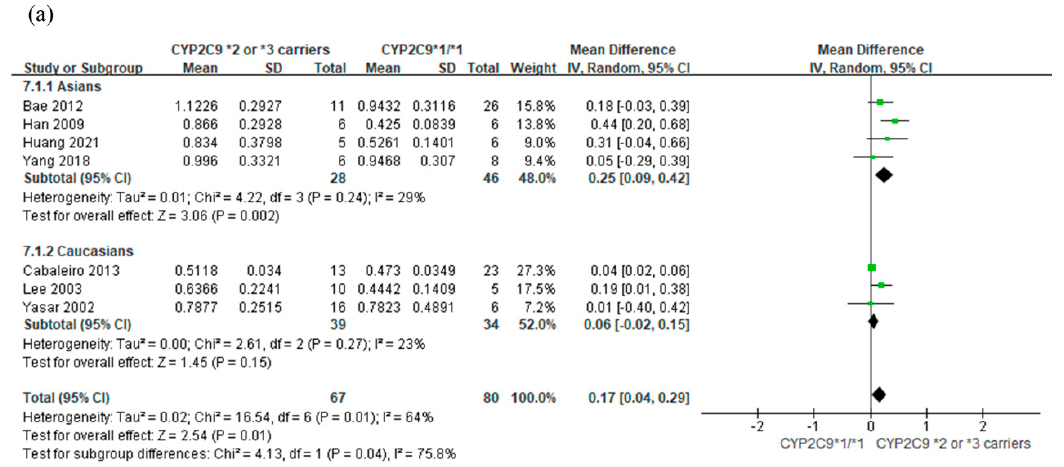
Figure 4. Forest plot with subgroups of Asians and Caucasians for comparing the mean difference between CYP2C9*2 or *3 carriers and CYP2C9*1/*1. ( a ) AUC 0- ∞ ( μg ∙ h/mL ) of losartan and ( b ) AUC 0- ∞ ( μg ∙ h/mL ) of E-3174. Sensitivity Analysis To assess the stability of the results, a sensitivity analysis was performed by sequen- tially excluding each study. Sensitivity analysis of AUC 0- ∞ of losartan and E-3174 showed similar results to the main analysis; MD between CYP2C9*2 or *3 carriers and CYP2C9*1/*1 ranged from 0.09 to 0.22 for AUC 0- ∞ of losartan and − 0.54 to − 0.25 for AUC 0- ∞ of E-3174, respectively. When the study by Cabaleiro et al. was eliminated, the heterogeneity of losartan AUC 0- ∞ decreased from 64% to 11% [16]. 4. Discussion This is the first meta-analysis to evaluate the effect of CYP2C9 gene polymorphisms on the pharmacokinetic properties of losartan. The results showed that CYP2C9*2 or *3 carriers had a higher AUC 0- ∞ of losartan and lower AUC 0- ∞ of E-3174 than those with CYP2C9*1/*1 . There was no significant difference in the C max of losartan between subjects with CYP2C9*2 or *3 and CYP2C9*1/*1, whereas the subjects with CYP2C9*2 or *3 carriers had lower C max of E-3174 than those with CYP2C9*1/*1 . The half-lives of both losartan and E-3174 were longer in CYP2C9*2 or *3 carriers than CYP2C9*1/*1 . Similar results were obtained in the comparison between CYP2C9*1/*1 and CYP2C9*3 carriers. There was an ethnic difference in the effects of CYP2C9 gene polymorphisms on the AUC 0- ∞ values of losartan and E-3174 between Asians and Caucasians. There are several studies on the effect of CYP2C9 inhibitors, such as fluconazole, bucolome, and ticlopidine, on the pharmacokinetic parameters of losartan. An in vitro study revealed that the C max and AUC 0- ∞ of E-3174 significantly decreased to 30% and 47% by fluconazole, respectively, compared to the control group [22]. Kobayashi et al. reported that concomitant use of losartan and bucolome resulted in the significant decrease of AUC 0- ∞ of E-3174 and increase of AUC 0- ∞ of losartan in healthy male volunteers [23]. There was also a report that ticlopidine increased the AUC 0- ∞ of losartan in rats [24]. The aforementioned studies indicate that the CYP2C9 enzyme was a significant metabolizer of losartan.